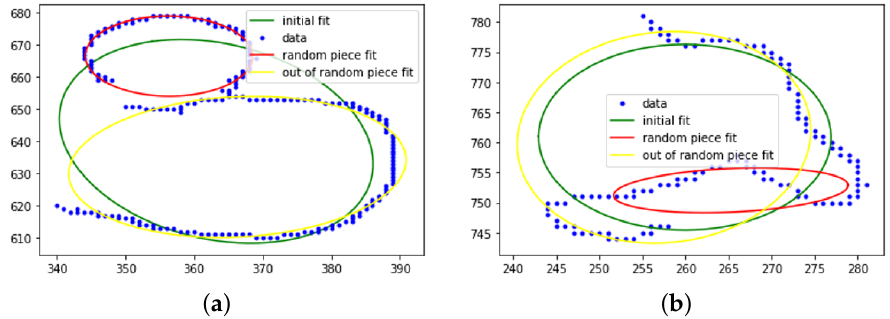
Figure 16. ( a ) Sample of successful bubble separation fitting into one cluster. ( b ) Sample of a bad fit of the unsuccessfully defined boundary. For both figures blue dots correspond to the data obtained, green colored lines indicate a fit by single ellipse for the entire cluster at once, red ones show the ellipse resulting from fitting a randomly selected arc, while yellow colored curves indicate the ellipse obtained as a result of fitting points located at a significant distance from the red ellipse.